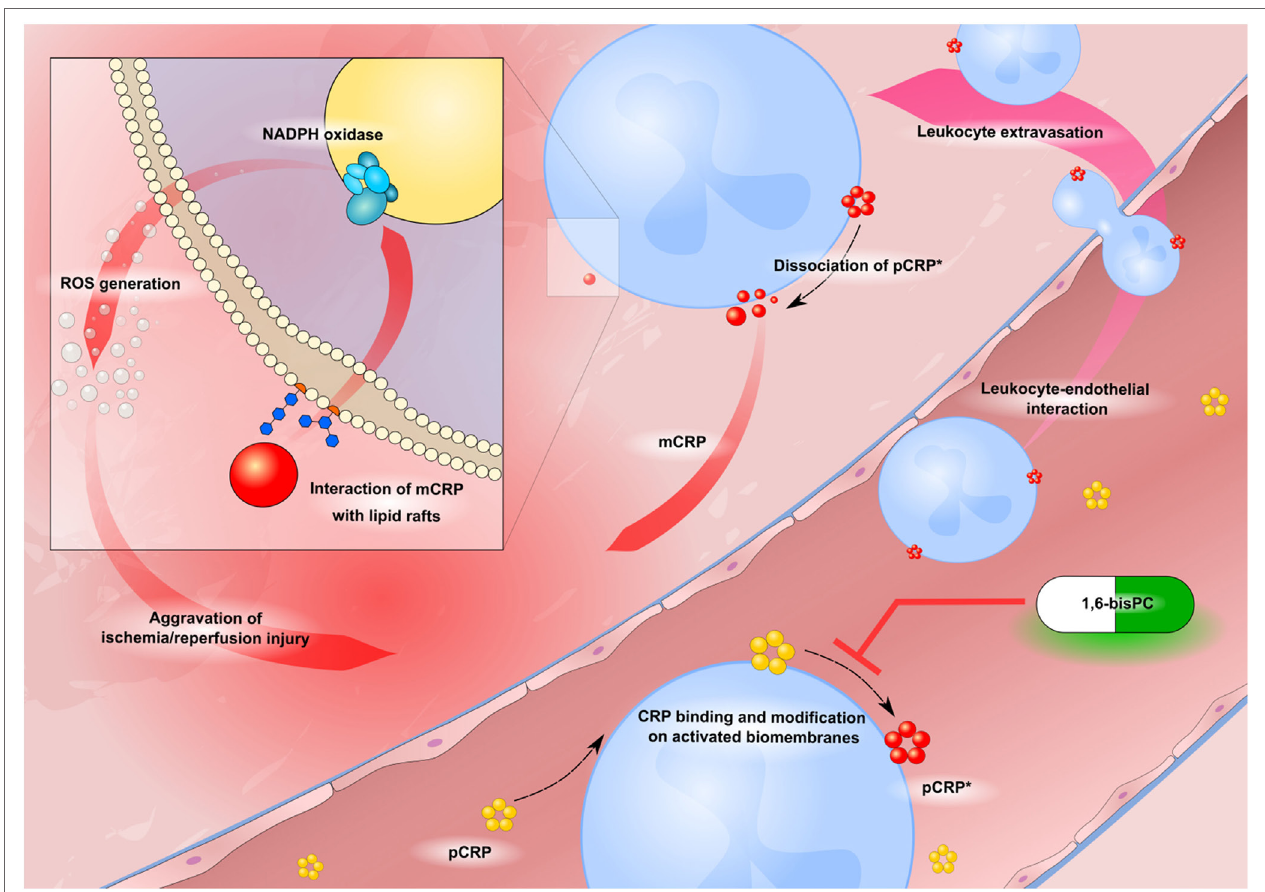
FigUre 6 | Schematic drawing of CRP-driven leukocyte response in ischemia/reperfusion injury (IRI). Circulating pentameric C-reactive protein (pCRP) (yellow) binds to activated biomembranes in the microcirculation of inflamed tissue. It is subsequently conformationally altered to bioactive pCRP*, dissociates and forms mCRP (red circles). Neo-epitope expressing CRP induces leukocyte–endothelial interaction and activation of the ROS producing NADPH oxidase enzyme complex. 1,6-bisPC (green–white pill) prevents the CRP-mediated leukocyte activation by stabilizing the native pentameric isoform of